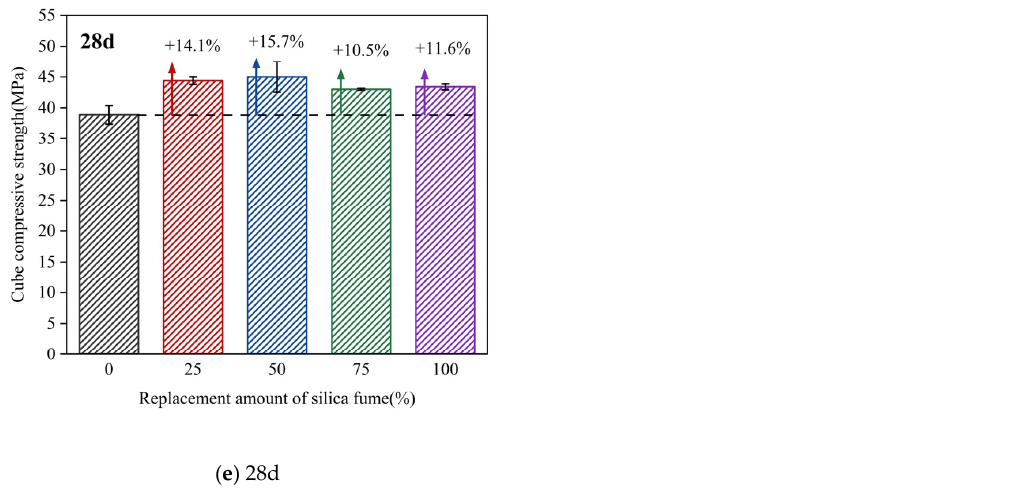
Figure 6. Comparison of compressive strength of concrete cubes with different replacement amounts of silica fume at different curing ages: ( a ) 1 d; ( b ) 3 d; ( c ) 7 d; ( d ) 14 d; ( e ) 28 d.